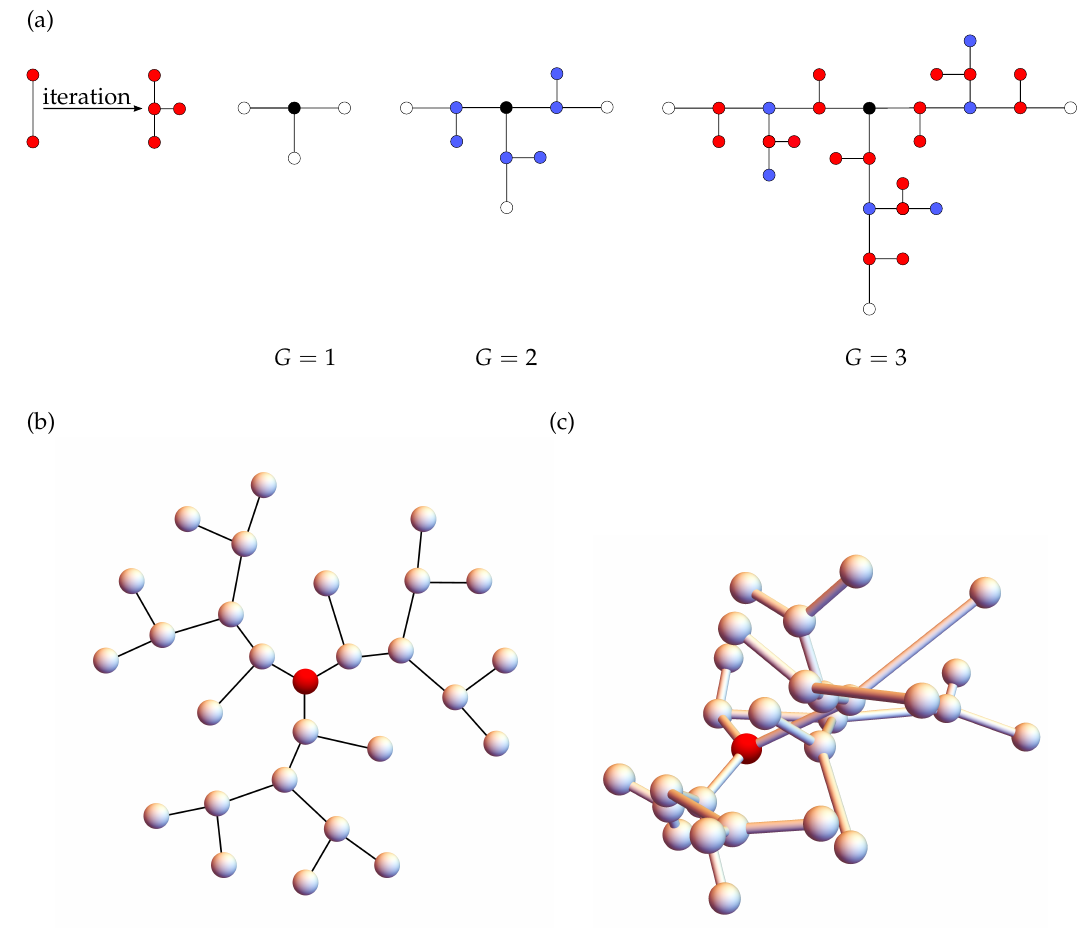
Figure 1. (a) Iterative construction of a T-fractal up to generation G = 3. The beads added Figure 1. ( a ) Iterative construction of a T-fractal up to generation G = 3. The beads in the second and in the third iteration steps are coloured by blue and red, respectively. (b) A added in the second and in the third iteration steps are colored by blue and red, respectively; two-dimensional representation of a T-fractal of generation G = 3 and (c) its random configuration in ( b ) A two-dimensional representation of a T-fractal of generation G = 3, and ( c ) its random three-dimensional space. configuration in three-dimensional